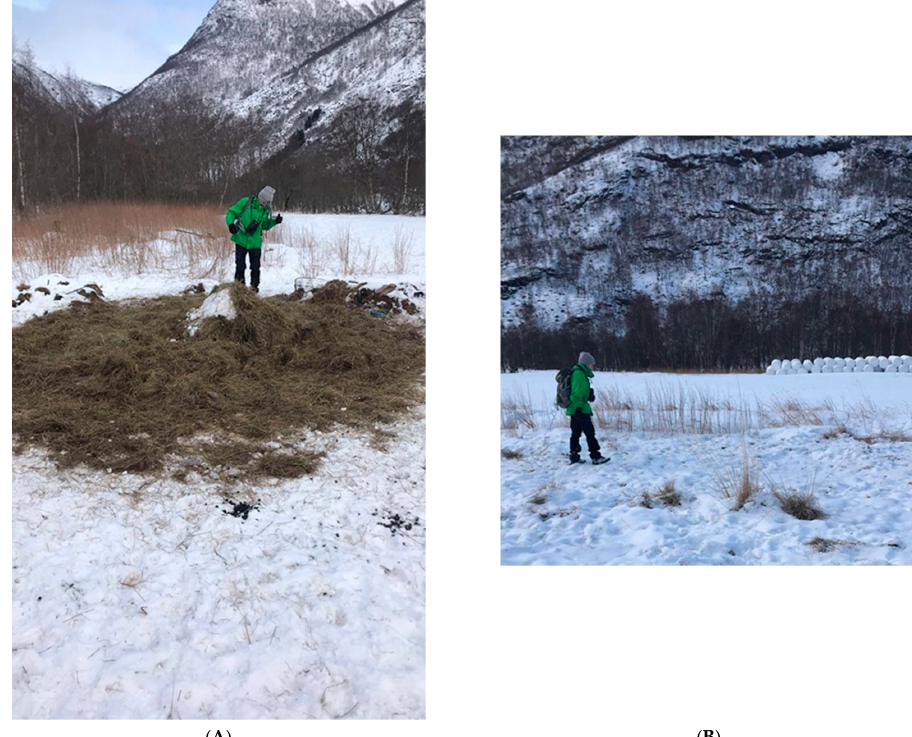
Figure 6. ( A ) The main driver of spatial clustering on agricultural fields was leftover silage from livestock farming. ( B ) Hay bales stored in on agricultural fields without being fenced.